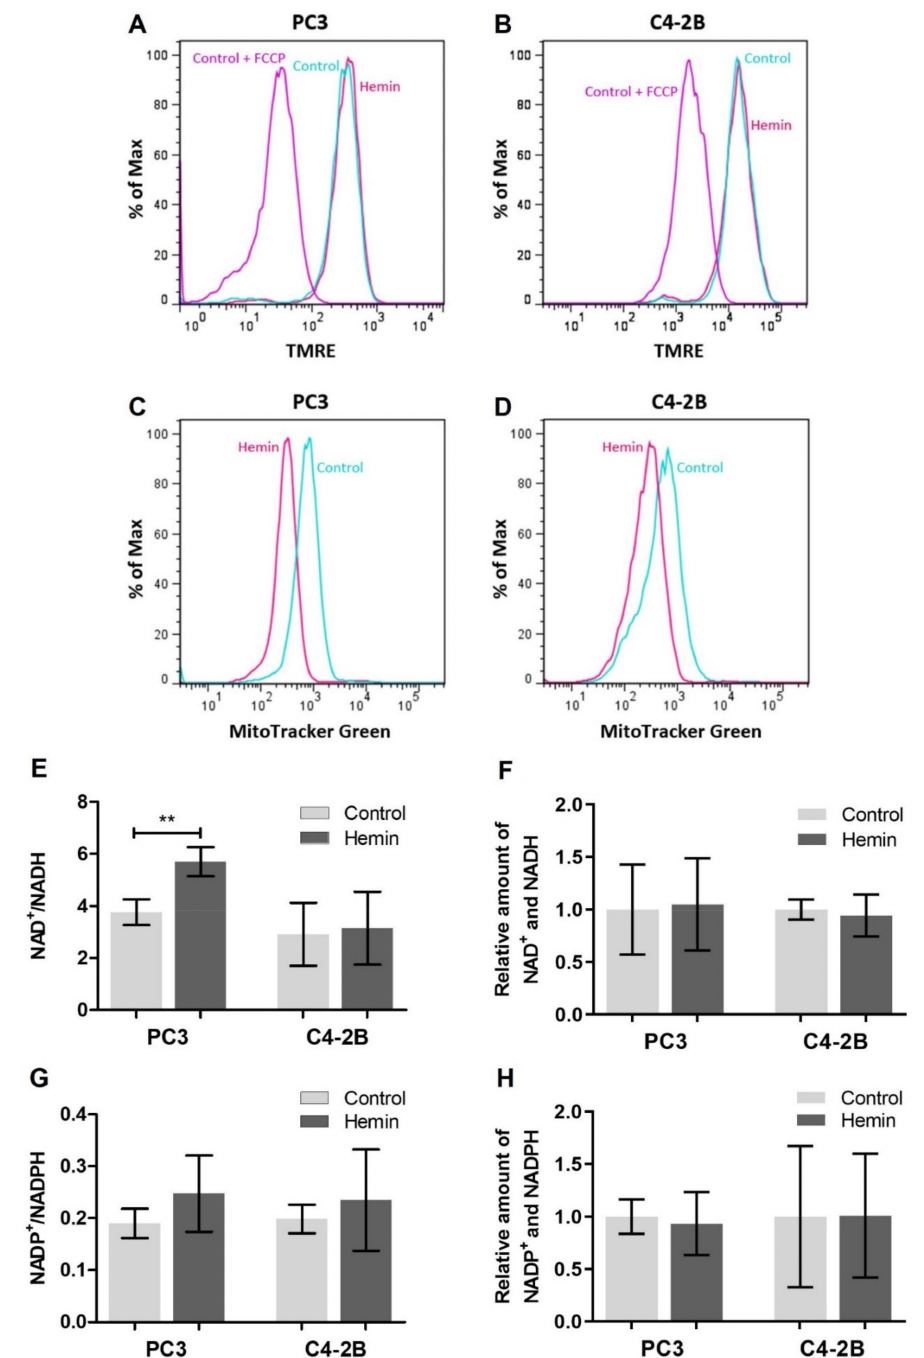
Figure 3. Mitochondrial status and redox balance in PCa cell lines under HO-1 induction. ( A ) PC3 and ( B ) C4-2B mitochondrial integrity evaluated after hemin treatment by flow cytometry using the potential-sensitive dye TMRE. Pre- treatment of control cells with the potent uncoupler of mitochondrial oxidative phosphorylation, FCCP (carbonyl cyanide 4-(trifluoromethoxy)phenylhydrazone), was used to determine the baseline. One representative of three independent experiments is shown. ( C ) PC3 and ( D ) C4-2B total mitochondrial mass was assessed after hemin treatment by flow cytometry using MitoTracker Green. One representative of three independent experiments is shown. ( E ) NAD + /NADH ratio and ( F ) total amount of NAD + and NADH (normalized to the control) were determined using the NAD/NADH-Glo Assay (Promega, USA). Data are presented as mean ± SD of three independent experiments, each performed in triplicate. ( G ) NADP + /NADPH ratio and ( H ) total amount of NADP + and NADPH (normalized to the control) were measured with the NADP/NADPH-Glo Assay (Promega, USA). Results are shown as mean ± SD of three independent experiments, each performed in triplicate. Significant differences: ** p <